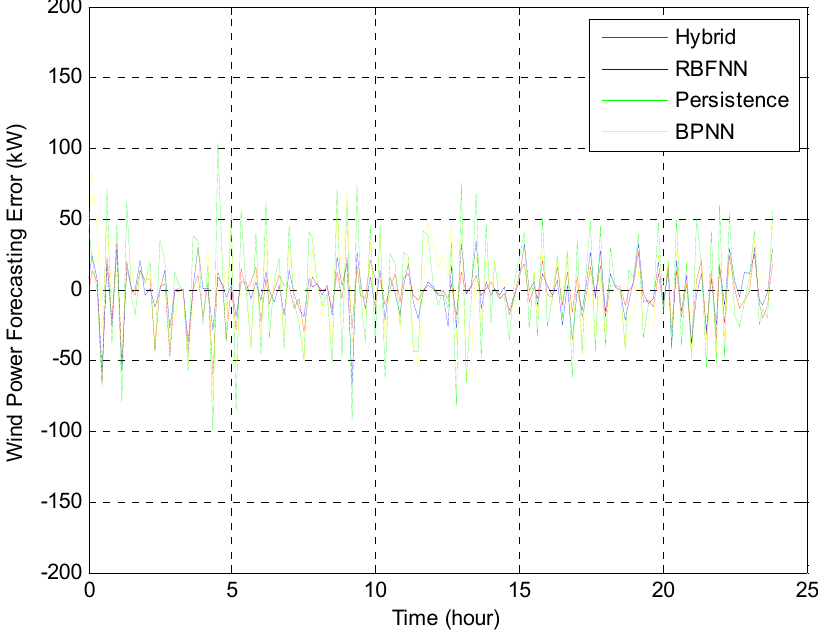
Figure 12. The forecasting error curves of four methods for typical summer